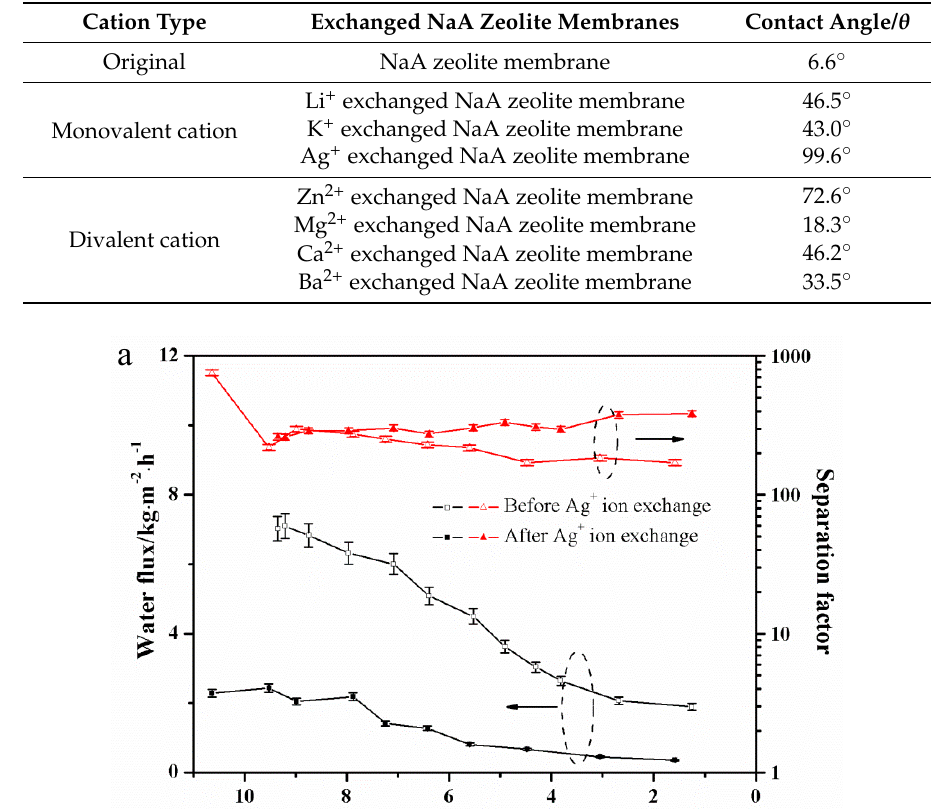
Table 5. The contact angles of the NaA zeolite membrane treated by different cations.